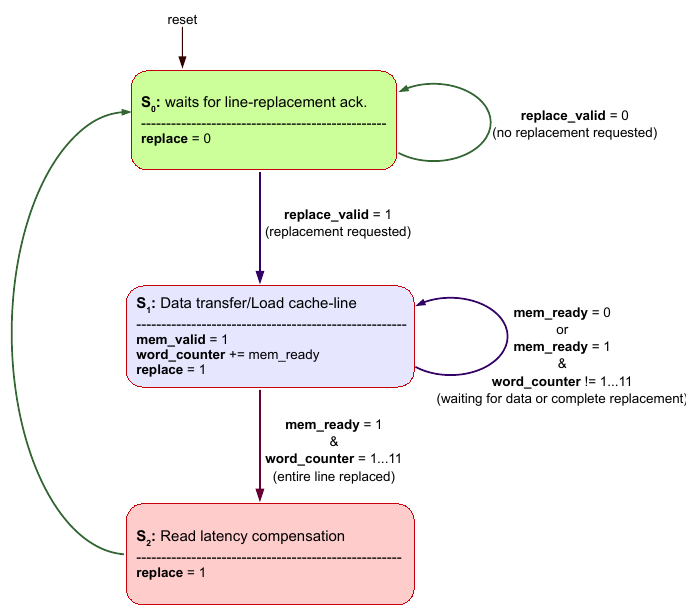
Figure 9. Back-End read-channel native